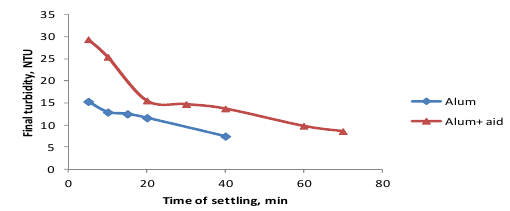
Fig.9. Effect of coagulant aid on the settling